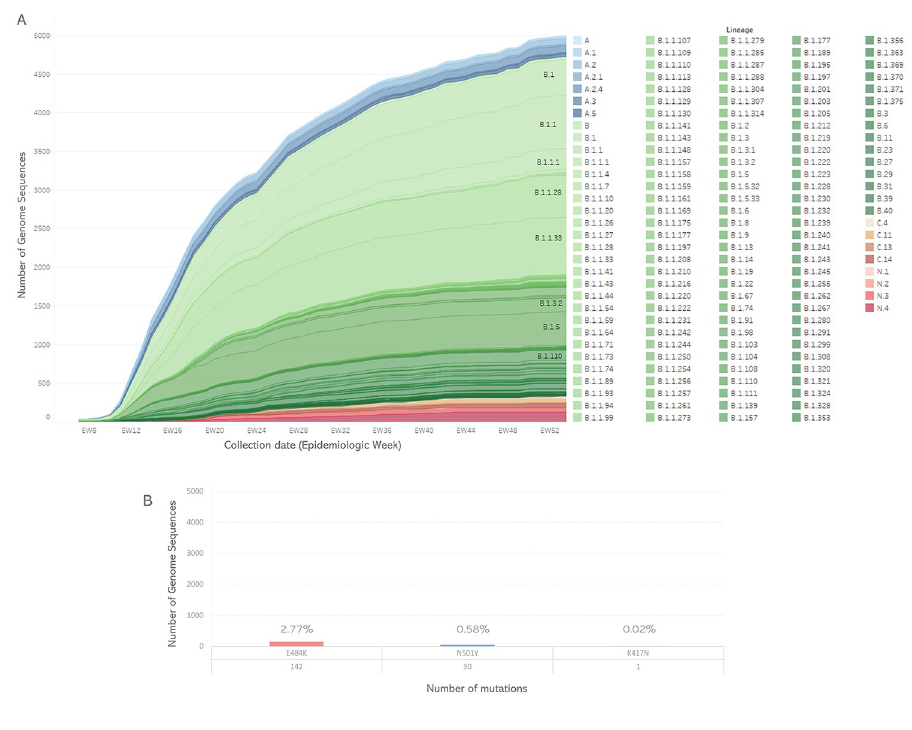
Fig 2. (A) Genetic groups and (B) E484K, N501Y and K417N spike mutations identified among SARS-CoV-2 circulating in Latin America and the Caribbean regions, epidemiologic weeks